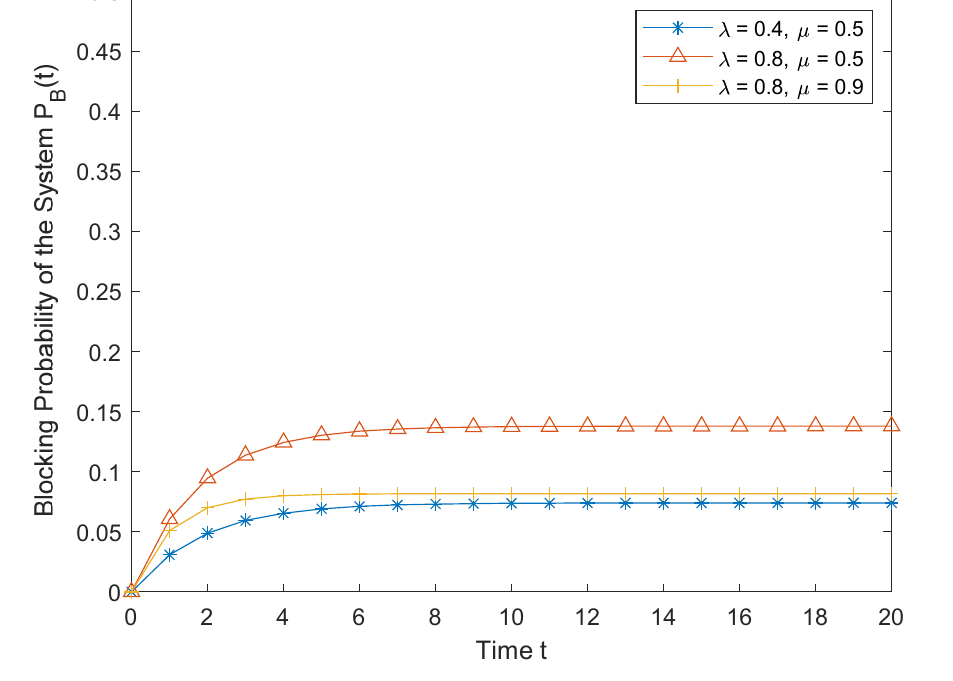
Figure 2. The blocking probability of the system P B (t).